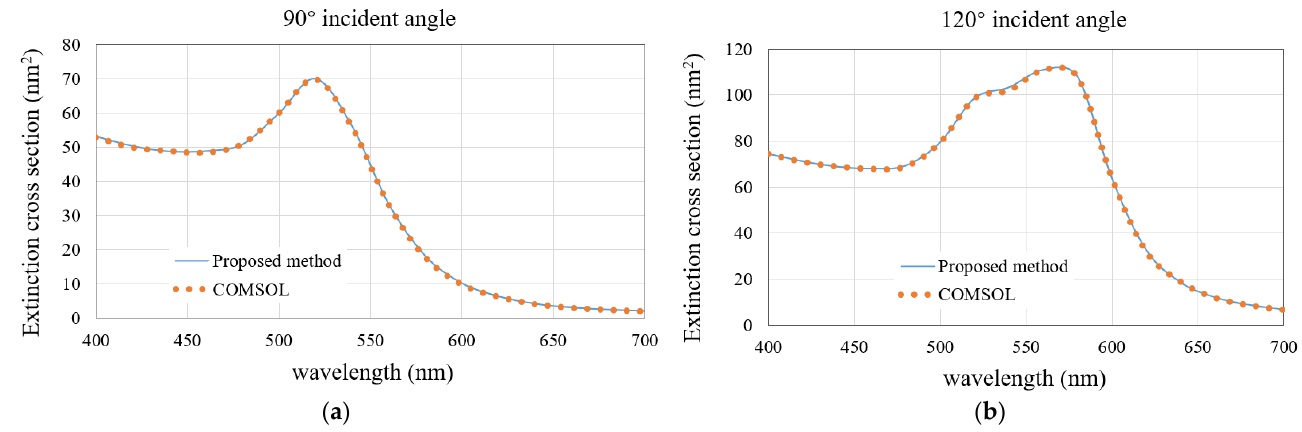
Figure 13. Comparison of the ECS results obtained by the proposed method and the COMSOL software for the nano-truncated cone array. ( a ) 90 ◦ incident angle; ( b ) 120 ◦ incident angle. Figure 14a,b show the surface-current distributions at a wavelength of 620 nm at an incident angle of 120 ◦ and an incident angle of 180 ◦ , respectively. In the case of 120 ◦ , the field-enhancement phenomenon is more obvious in the region close to the incident wave, and when the incident angle becomes 180 ◦ , the surface current distribution is uniform.